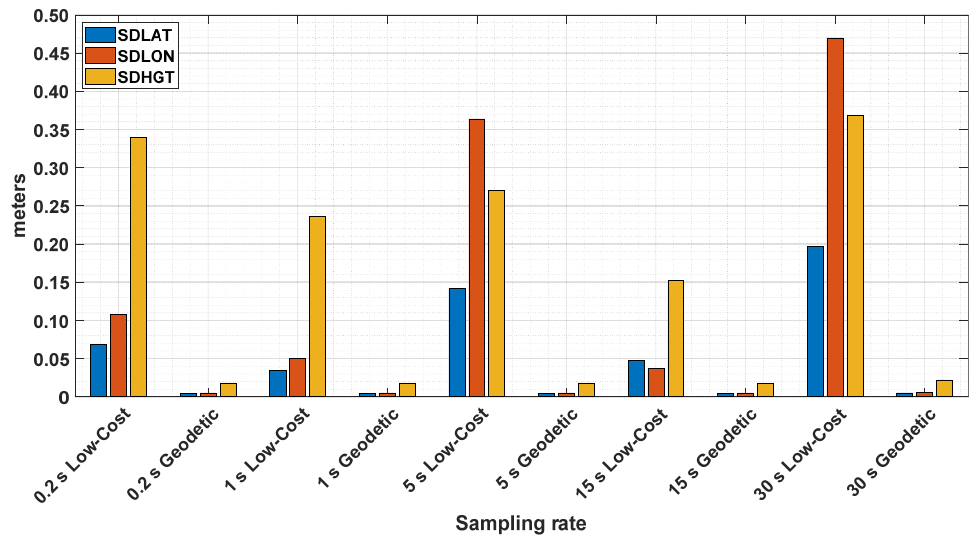
Figure 7. Standard deviation (95%) of estimated positions of low-cost and geodetic receivers by processing with PPP-static mode.